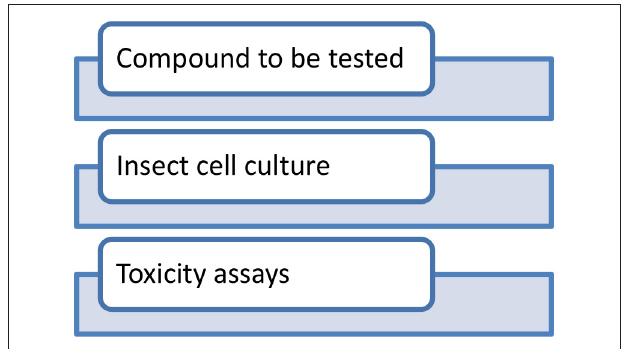
Most insect cells can be cultivated over a temperature range cell lines utilize a phosphate buffering system (Lynn, 2002).